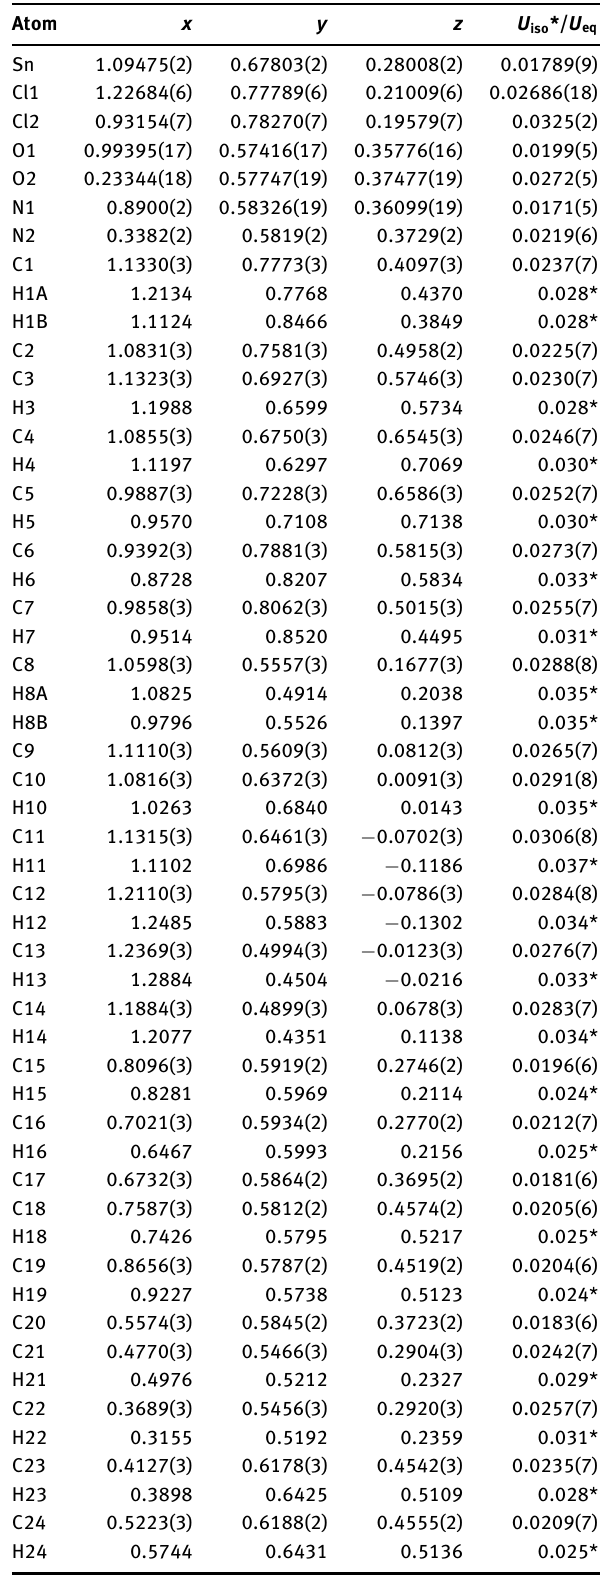
Table 2: Fractional atomic coordinates and isotropic or equivalent isotropic displacement parameters (Å 2